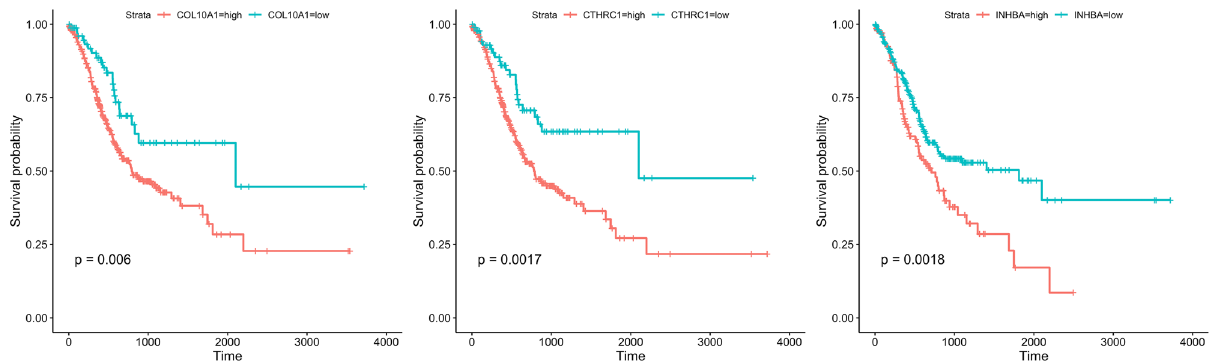
Figure 6. Kaplan–Meier survival curves based on COL10A1, CTHRC1, and INHBA expression levels. The cut-off values classified gene expression as high (high) or low (low). The horizontal axis represents survival time (days), and the vertical axis represents overall survival